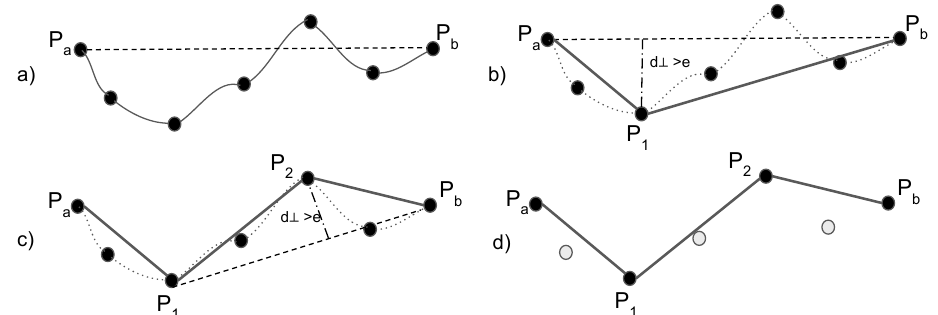
Figure 7. Douglas–Peucker algorithm. ( a ) Line segment formed by anchor and float points. ( b ) The point ( P 1 ) with the maximum perpendicular distance from line segment is selected. ( c ) The process is repeated using recursion on each line segment. ( d ) New simplified trajectory.